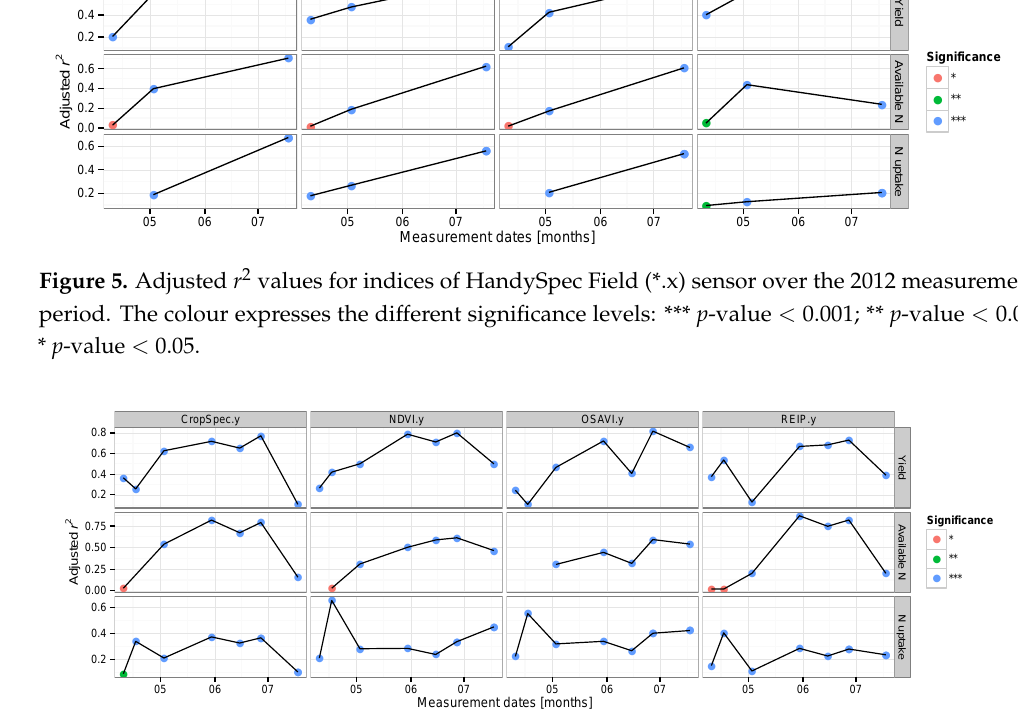
Figure 6. Adjusted r 2 values for indices of FieldSpec HandHeld (*.y) sensor over the 2012 measurement period. The colour expresses the different significance levels: *** p -value < 0.001; ** p -value < 0.01; * p -value < 0.05.